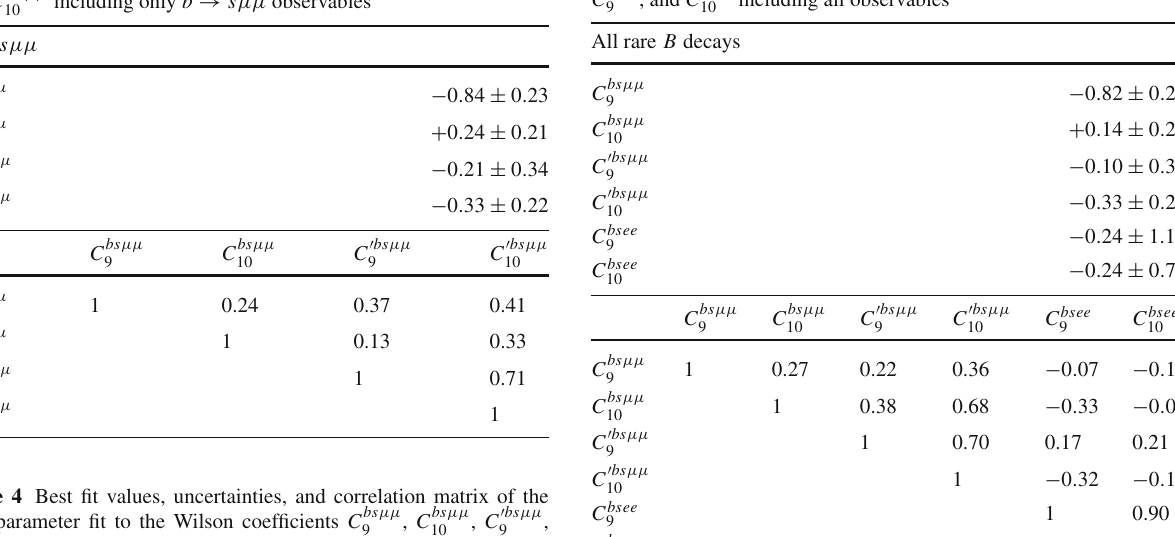
Table 3 Best fit values, uncertainties, and correlation matrix of the four-parameter fit to the Wilson coefficients C bs